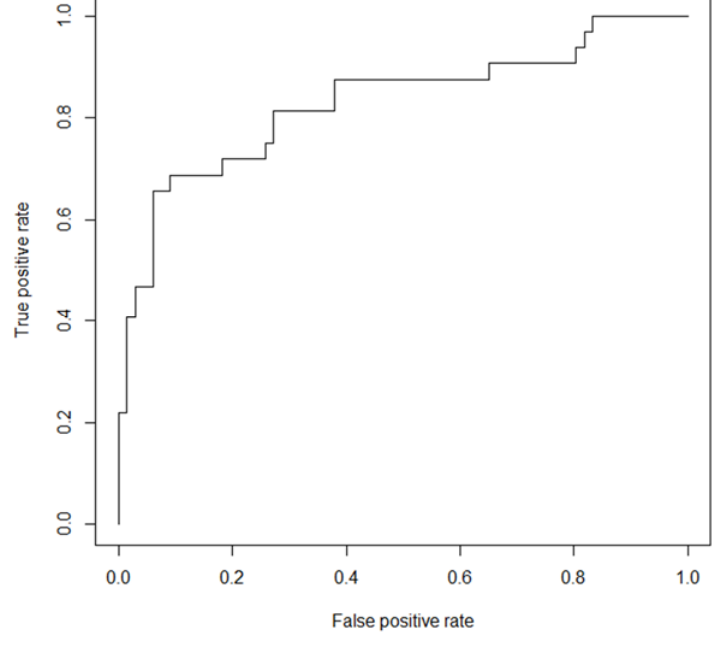
Figure 7. ROC curve for the Evangeline LR model.